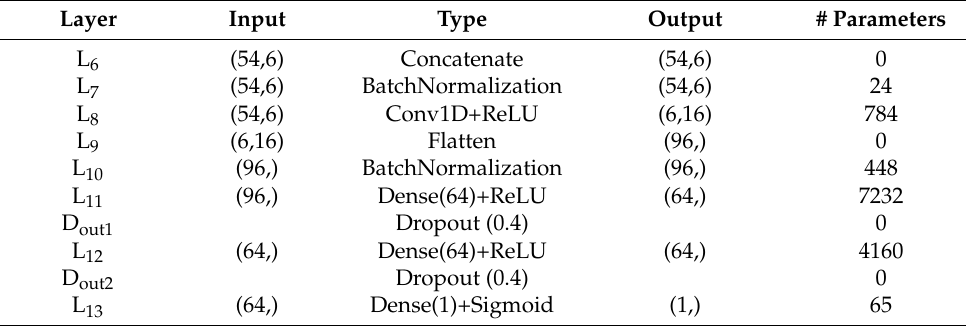
Table 3. Autoencoded CNN Layers’